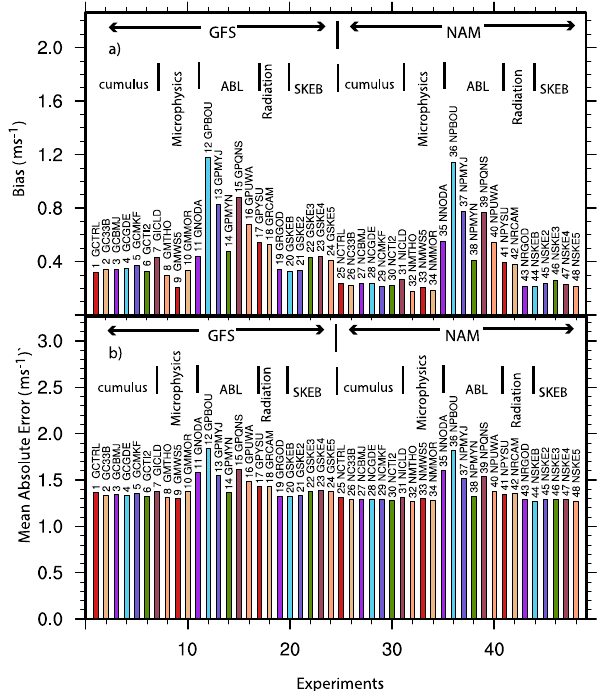
Figure 9. Averages on Domain 3 of ( a ) bias and ( b ) MAE in WS10 from analyses during the one-week study period in January. The unit is m s − 1 .